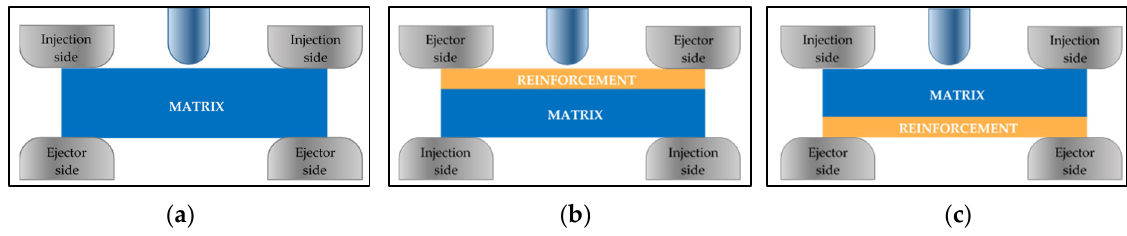
Figure 8. ( a ) Sample without fabric reinforcement. ( b ) Reinforced sample, ejector side. ( c ) Reinforced sample, injection side.